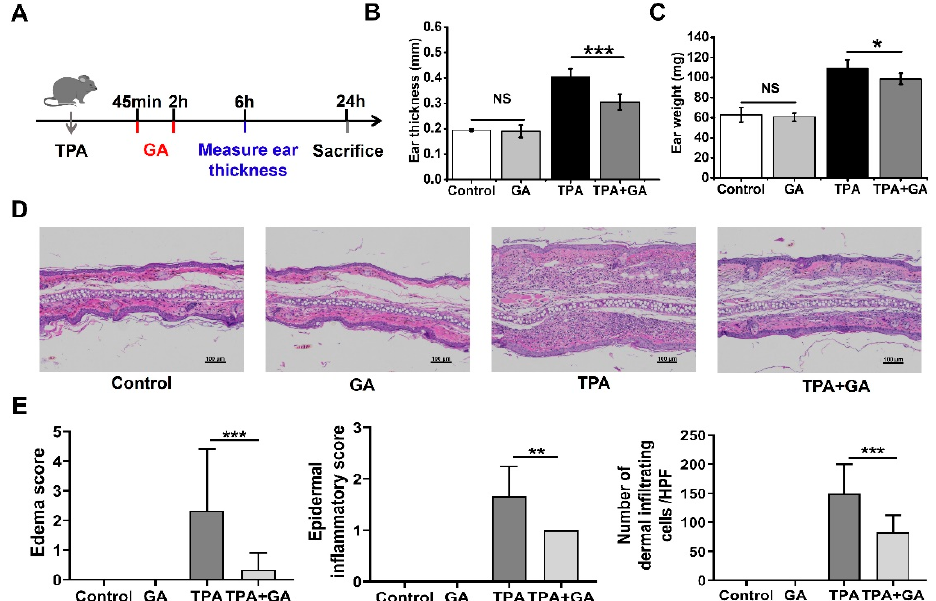
Figure 3. Effect of Au nanoclusters in 12-O-tetrachenol-13-acetate (TPA)-induced acute irritant contact dermatitis (ICD). ( A ) The mice were separated into four groups, and the ICD mouse model was established by applying TPA topically. The thickness ( B ) and weight of the ear ( C ) was measured 6 h after TPA treatment; n = 5 mice per group in the ICD model; * p < 0.05, *** p < 0.001; n.s., not significant. ( D ) Representative hematoxylin and eosin (H&E)-stained histopathologic slices of mouse ear tissue from each group. The magnification for all images is the same. Scale bar = 100 µm. ( E ) Dermal inflammatory score of the histopathological images. Data are the results of scoring three pathological sections per group and are expressed as the mean ± SD (n = 3); ** p < 0.01, *** p < 0.001.